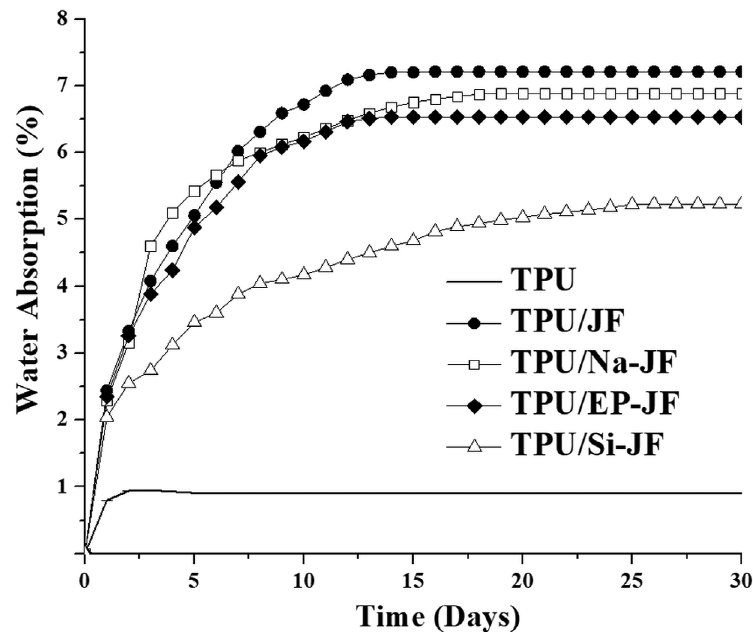
Figure 6: Water uptake curves of TPU and